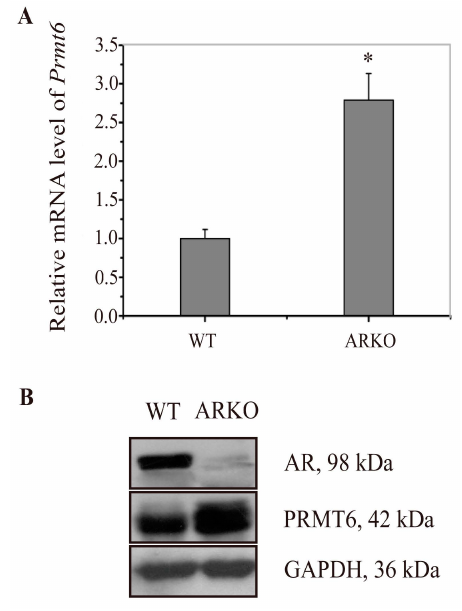
Figure 1. Increased expression of Prmt6 (protein arginine methyltransferase 6) mRNA and PRMT6 protein in the testes of ARKO (androgen receptor knockout) mice. ( A ) The expression of Prmt6 mRNA in the WT (wild type) and ARKO mouse testes were examined by RT-qPCR. The mean values of WT Prmt6 mRNA was set as 1, and ARKO Prmt6 mRNA was increased to 2.74 when compared with WT. Data were expressed as the mean ˘ SD (* p < 0.05, n = 5); ( B ) Representative graphs of the western